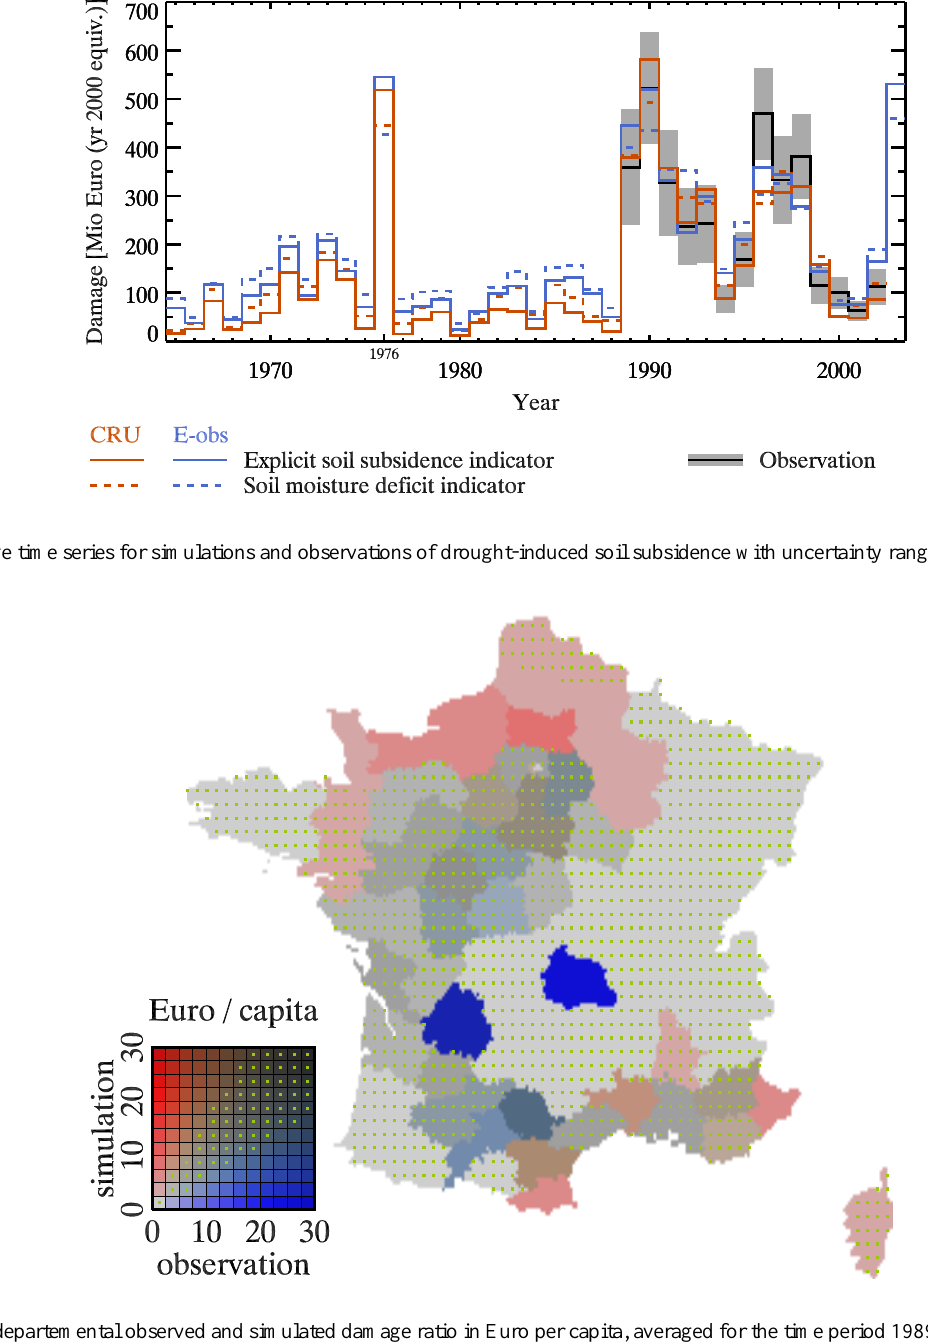
Fig. 5. Mean departemental observed and simulated damage ratio in Euro per capita, averaged for the time period 1989 to 2002. Simulation driven by E-OBS meteorological data set and explicit indicator for drought-induced soil subsidence. Stipples indicate an agreement within 50% between simulation and observation.